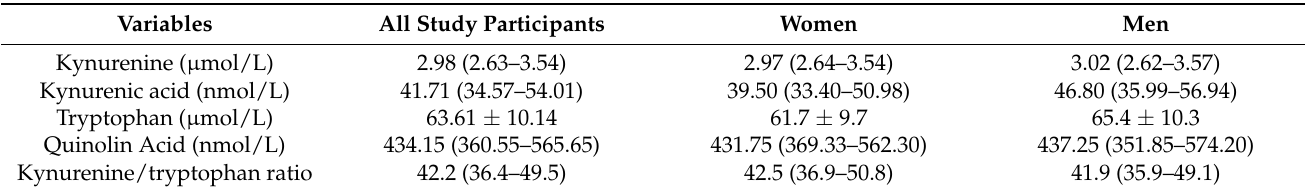
Table 3. Metabolites of the tryptophan–kynurenine pathway of all study participants.